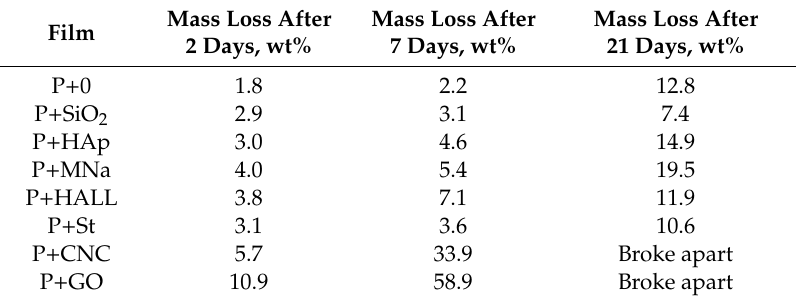
Table 4. Mass loss values after accelerated in vivo degradation